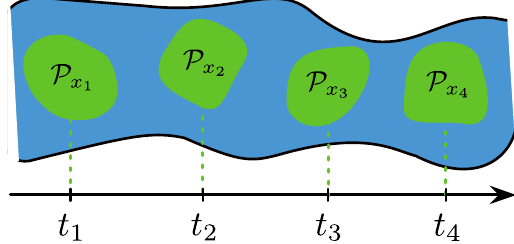
FIG. 1. Probing a process with projective measurements. At each time t , the process (depicted in blue) is probed by a j projective measurement (depicted in green) with outcomes x , j belongs to the same finite set X . If the resulting where each x j family of probability distributions P (depicted are the cases n n ≤ 4 ) satisfies the Kolmogorov consistency conditions, then